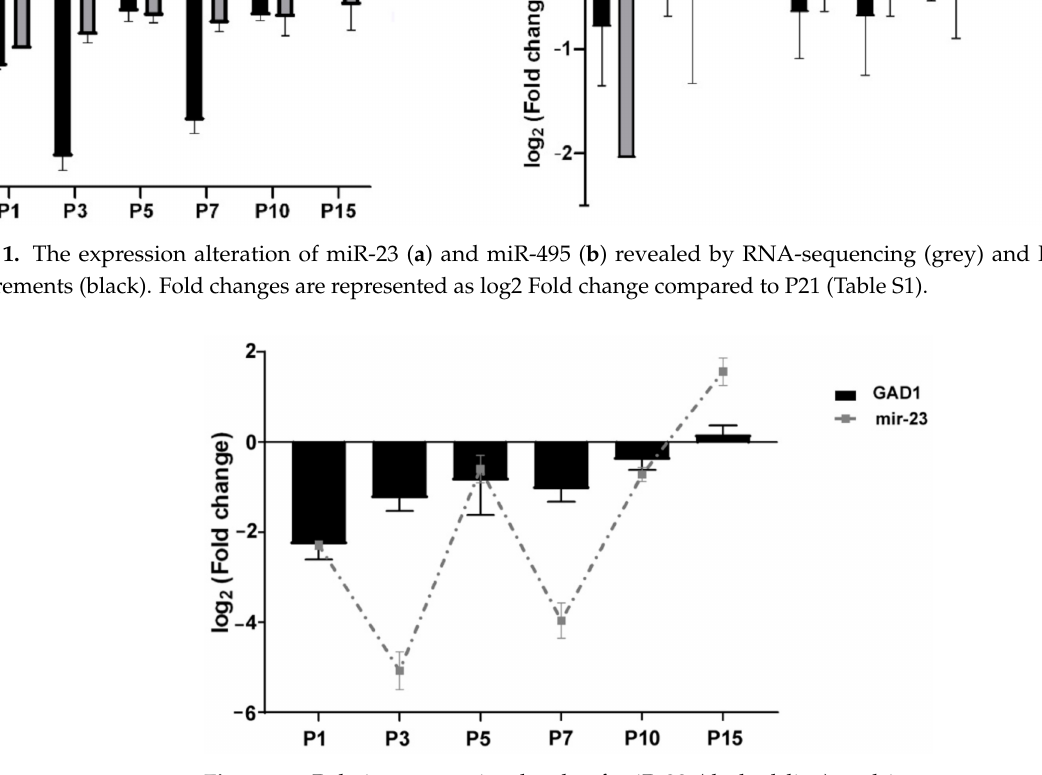
Figure 2. Relative expression levels of miR-23 (dashed line) and its target gene GAD1 (black) determined by RT-qPCR. Target gene expression level was normalized against glyceraldehyde-3- phosphate dehydrogenase (GAPDH) as an internal control gene. The change in miR-23 expression was calculated with U6snRNA as a reference gene for normalization. Expression was compared with P21 (Tables S1 and